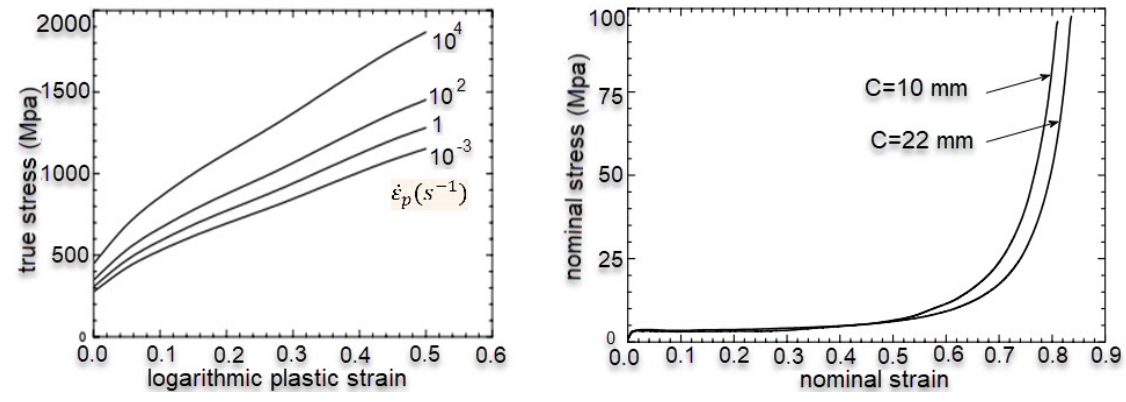
Figure 21: Stress-strain diagram.